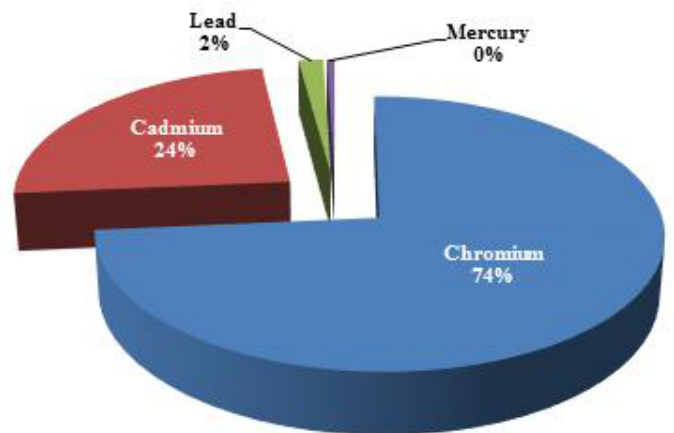
Fig. 3: Proportion of variation of heavy metals in the dry season, Cr >Cd > Pb> Hg